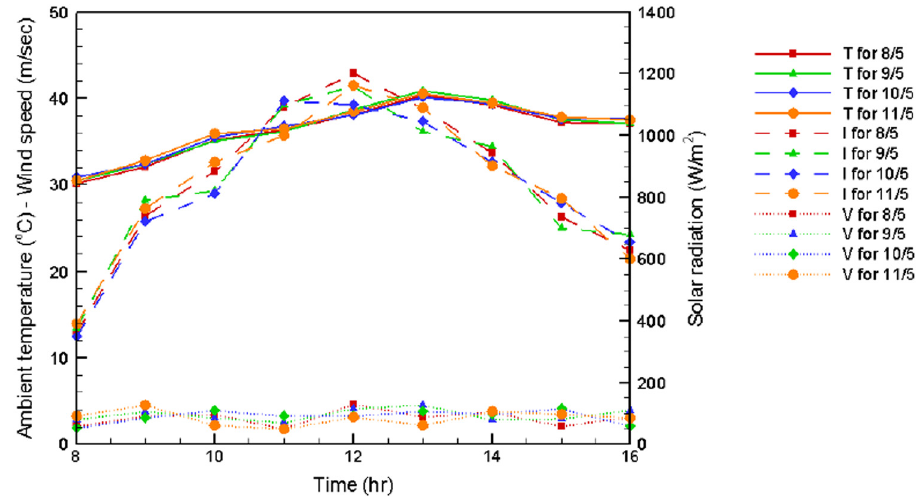
Figure 7: Ambient conditions for the experiments days ( May 8 – 11, 2021 ) ; T is the ambient temperature, I is the solar radiation, and V is the wind